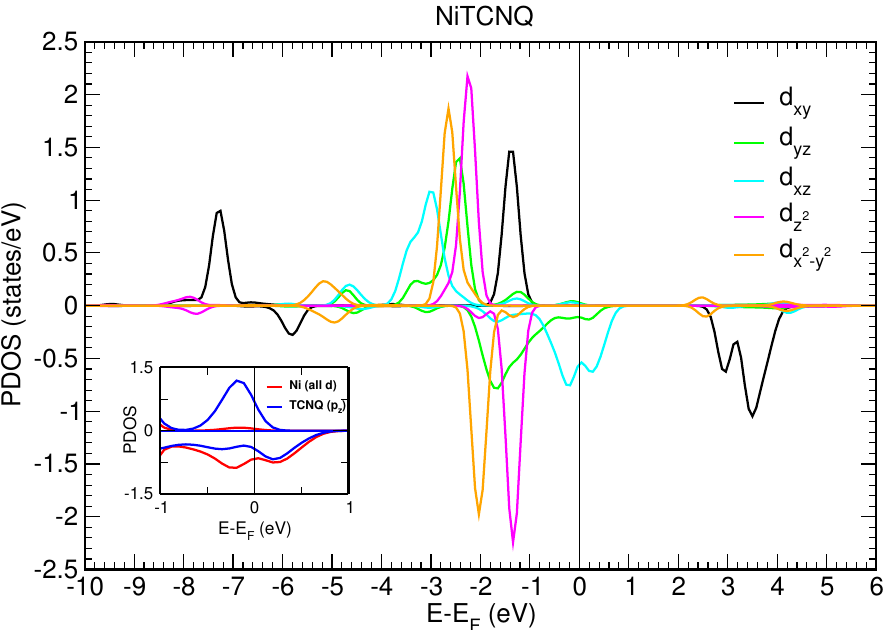
Figure 7. Projected density of states onto the five different Ni(3d) orbitals for Ni–TCNQ. The inset shows the PDOS onto p orbitals of C and N atoms in TCNQ, as well as onto all Ni(3d) orbitals, in a narrow energy range close to the Fermi level ( E F ). Note that the p z contributions of C and N atoms account for the